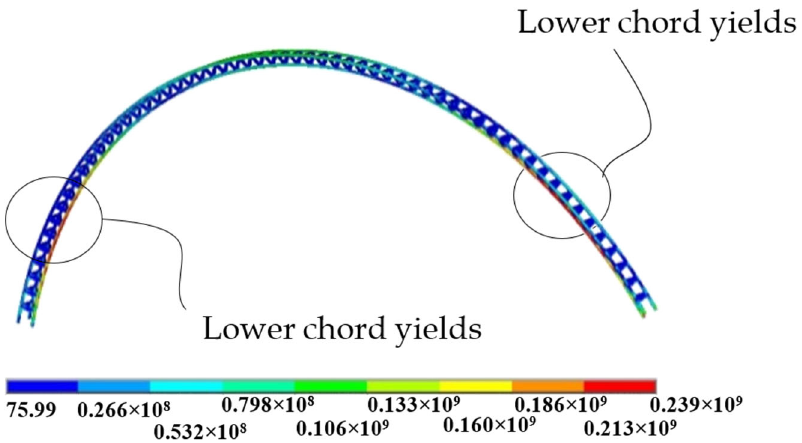
Figure 16. Global stress distribution at point B (Pa).